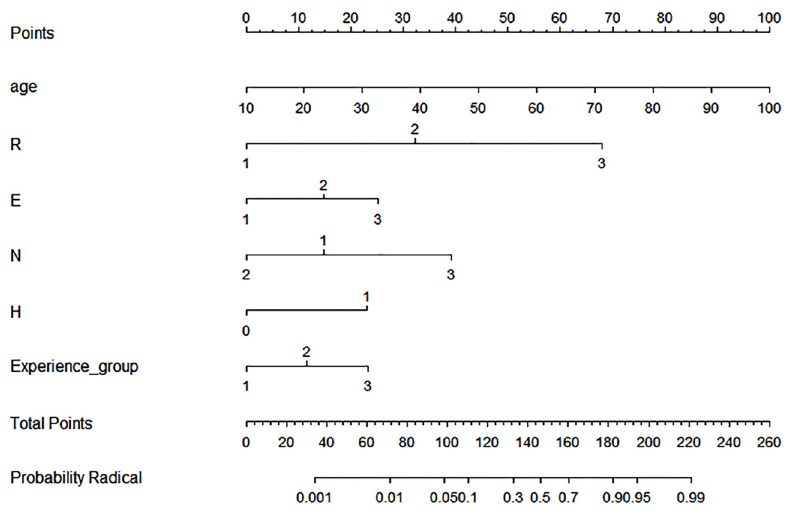
Fig 3. Nomogram (radical nephrectomy vs. partial